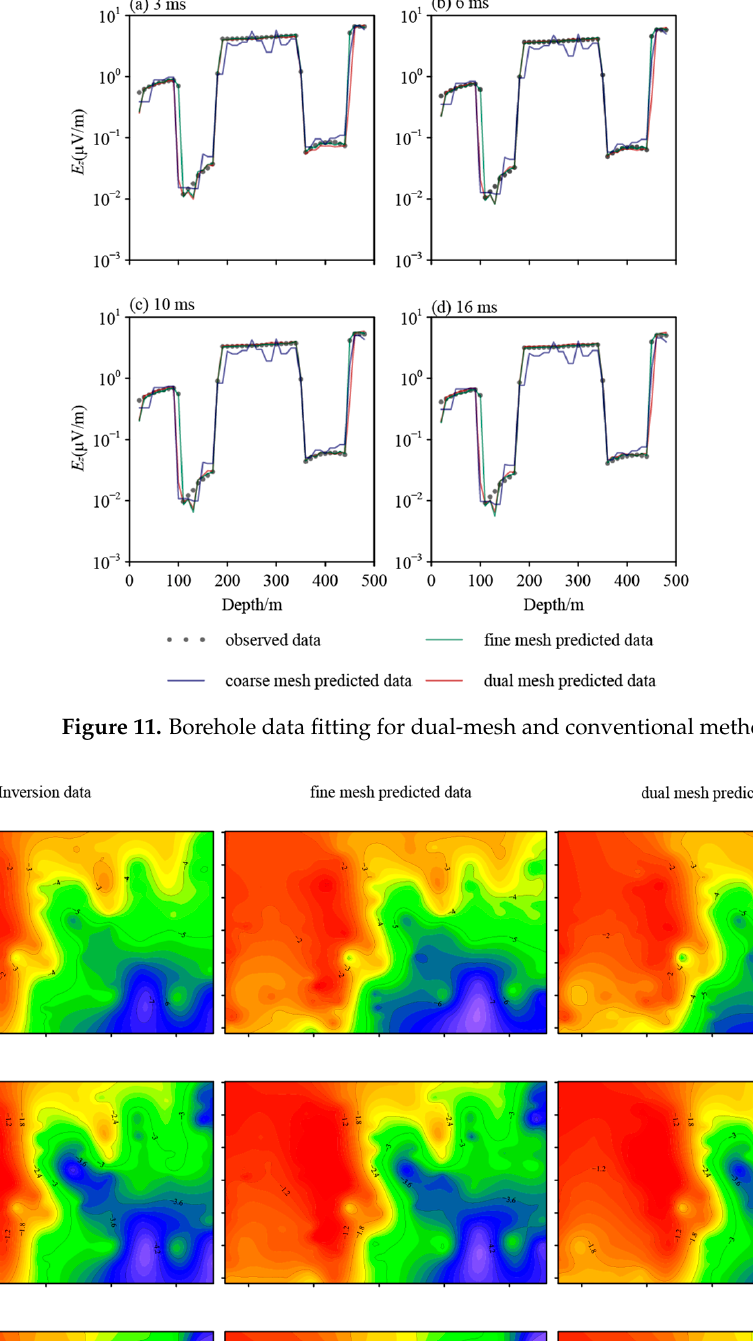
Figure 10. True model and inversion results from the dual-mesh and conventional methods: ( a , b ) true model; ( c , d ) conventional inversions; ( e , f ) dual-mesh inversions.